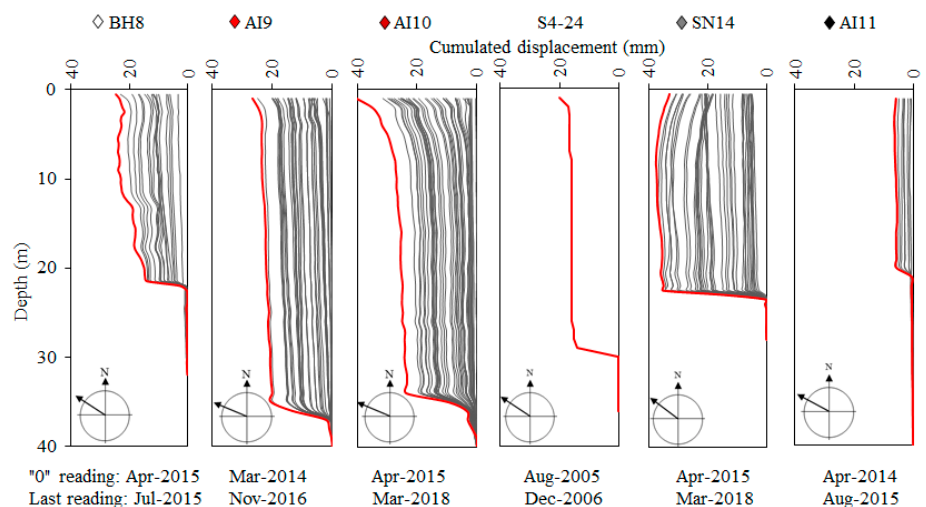
Figure 5. Historical inclinometer profiles obtained by manual readings (each grey line represents a reading of the inclinometer casing taken during the period indicated below the graph; the red line, instead, represents the most recent reading).